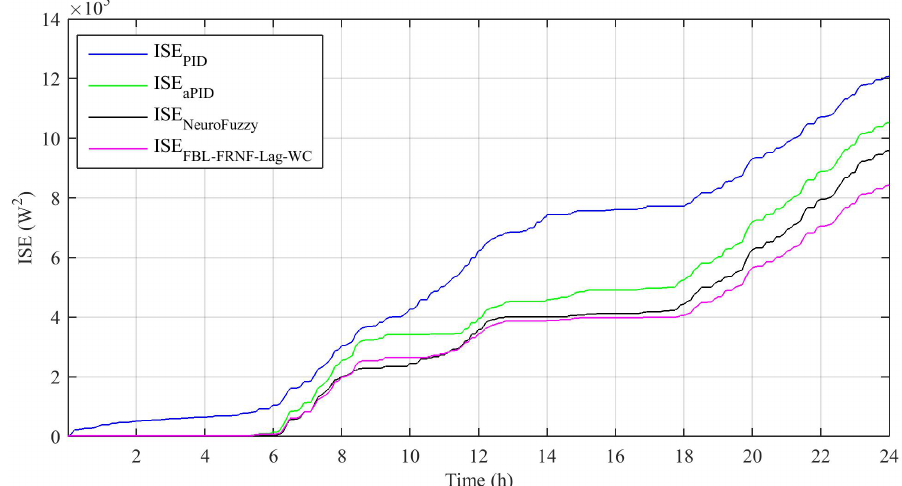
Figure 12. Integral squared error (ISE) evolution.